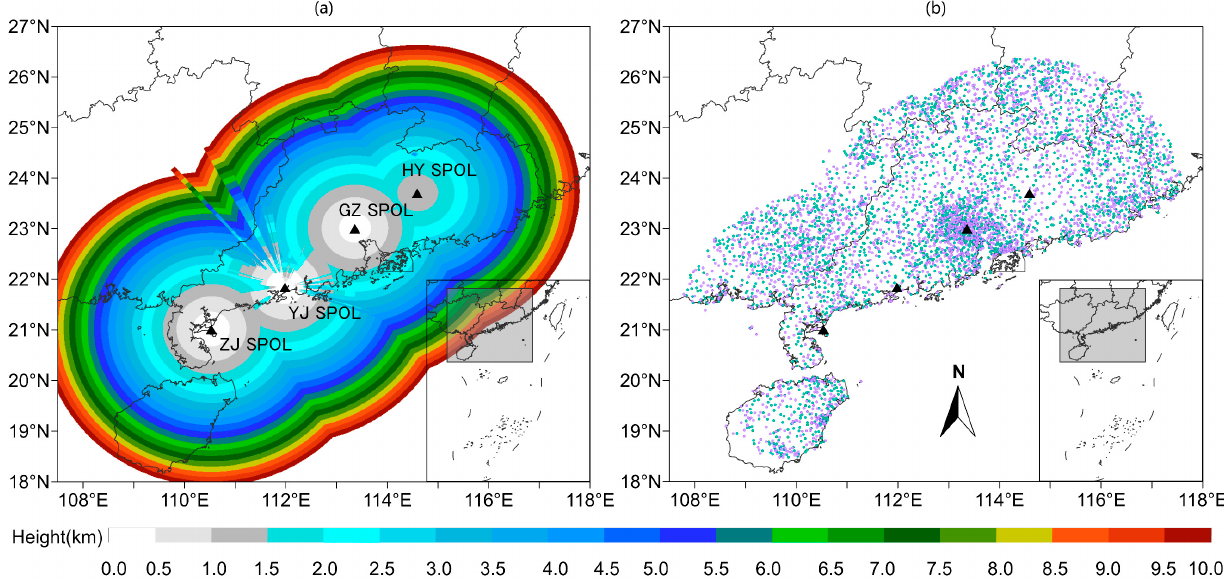
Figure 1. Distributions of the ( a ) S-band PR stations at Heyuan (HY), Guangzhou (GZ), Yangjiang (YJ), and Zhanjiang (ZJ) (black triangles and labeled as SPOL) and ( b ) RG stations (green and purple circles). The background colors in ( a ) indicate the mosaic height. The 5348 RG stations were evenly divided into two groups (green: 2681, purple: 2667) according to the spatial distribution. The gray rectangles in the insets show the extent of the study area and its location in Southern China.